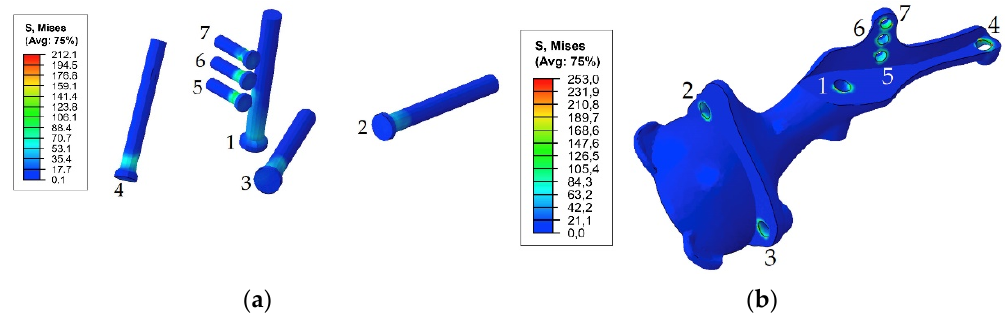
Figure 8. Equivalent von Mises stress (MPa) distribution caused by a pretension load of 1000 N: ( a ) in the screw system; ( b ) in the implant.